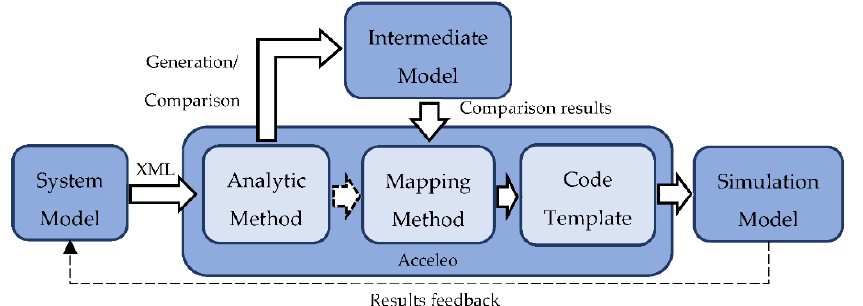
Figure 10. Model transformation and synchronization mode.